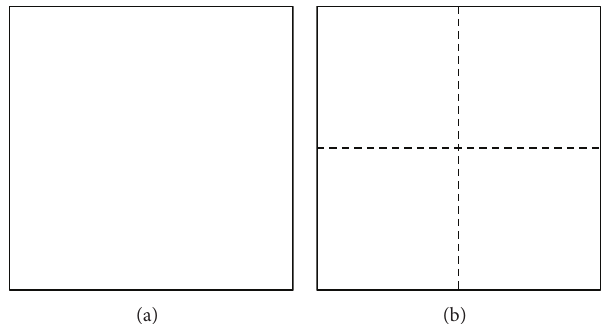
Figure 1: Mesh refinement.